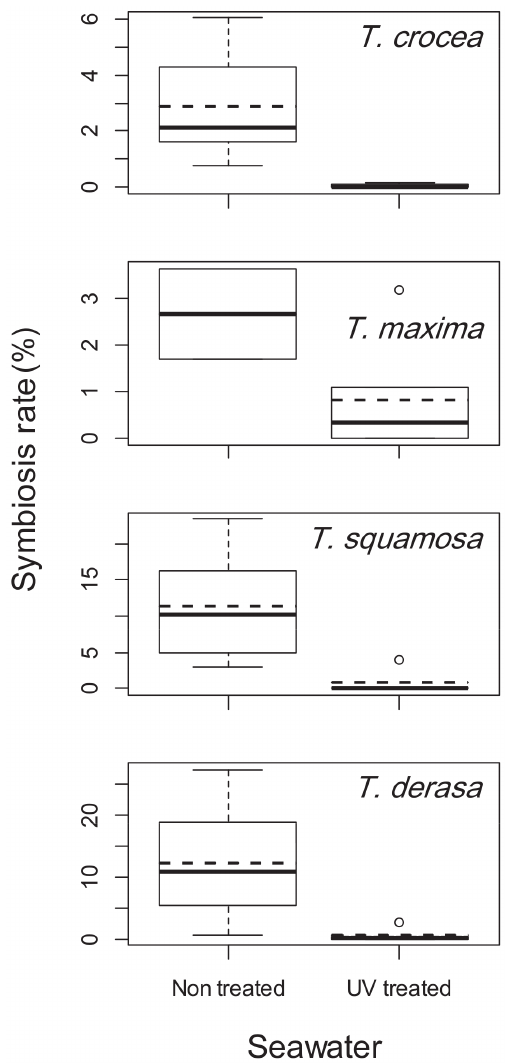
Figure 1. Symbiosis rates of Tridacna spp. in the hatchery observations. Showing what percentage of the seeds reared in non treated and UV treated seawater established a symbiotic relationship with Symbiodinium. Each box plot depicts the mean (dotted bar), the median (thick bar), the upper and lower quartile (upper and lower sides of the box, respectively), the lowest and highest sample within the 1.5 interquartile ranges of the lower and upper quartile (upper and lower tips of the vertical line, respectively), and outliers (circles).